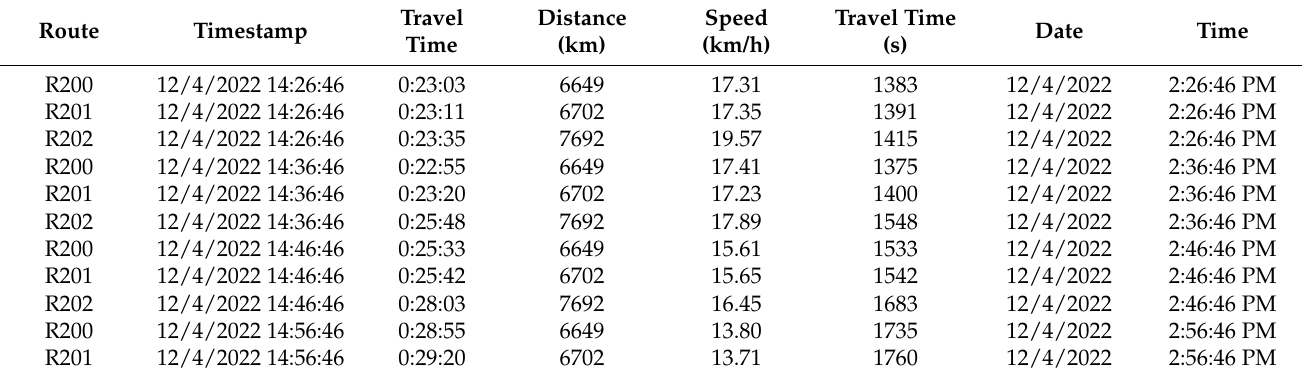
Table 2. Sample of automatic travel time and distance data from Google API.